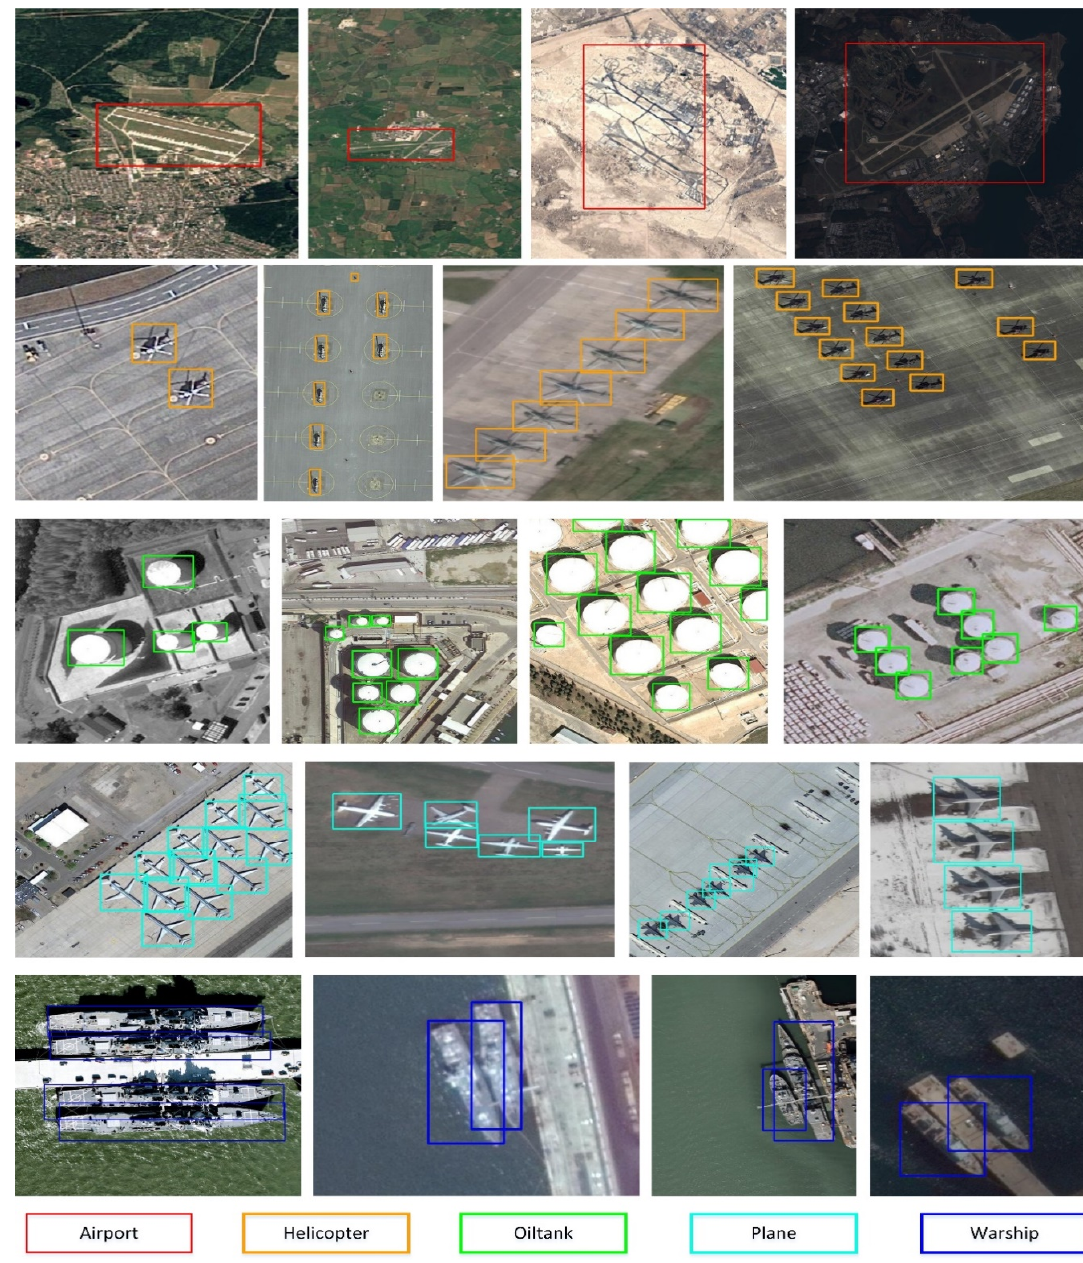
Figure 8. Example images and detection results on RSD-GOD dataset using the proposed approach.